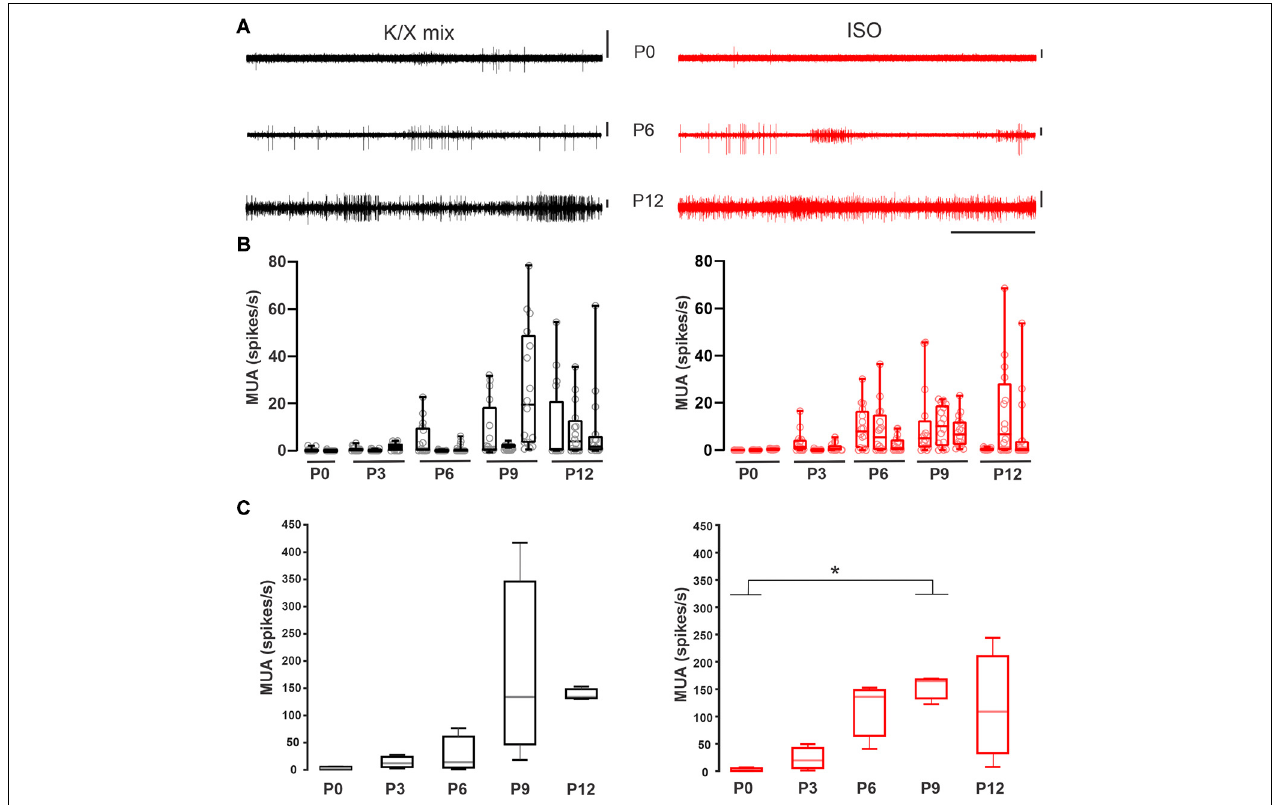
FIGURE 3 | Increase in multiunit activity in the MNTB before hearing onset. (A) Representative recordings acquired with a polytrode in the medial portion of the SOC of neonate rats. Exemplar recording at P0 (upper), P6 (middle), and P12 (bottom panel) under K/X mix (left) or ISO (right panel). Vertical scale bars = 100 µ V, horizontal scale bar = 5 s. Note the increase in the activity level along development. (B) Box plots for different animals illustrating the MUA frequency in each electrode (empty circles). (C) Quantification of the averaged multiunit activity per developmental stage. Boxes represent interquartile range between 25 and 75%. Whiskers indicate the minimum and maximum of all data. Inside line represents the median. Statistical analysis show differences under ISO displaying lower activity at P0 compared to P9 (K-W, p = 0.04; multiple comparisons, * indicates multiple comparisons, p < 0.05; n = 3).